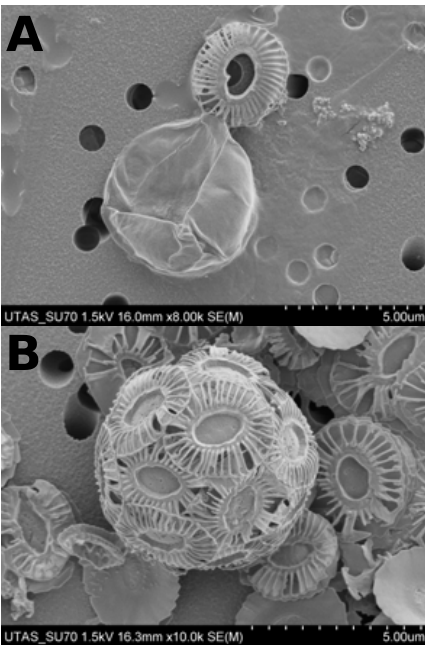
Figure 4. Representative SEM photographs of the under-calcified E. huxleyi strain SO-8.04 cultured at modern seawater Ca 2 + con- centration of 10mmolL − 1 , showing no or only single attached coc- coliths (a) . When cultured for 2 months at elevated Ca 2 + concen- tration of 36mmolCa 2 + kg − 1 , E. huxleyi strain SO-8.04 produced a sufficient number of coccoliths to cover the whole cell (b)